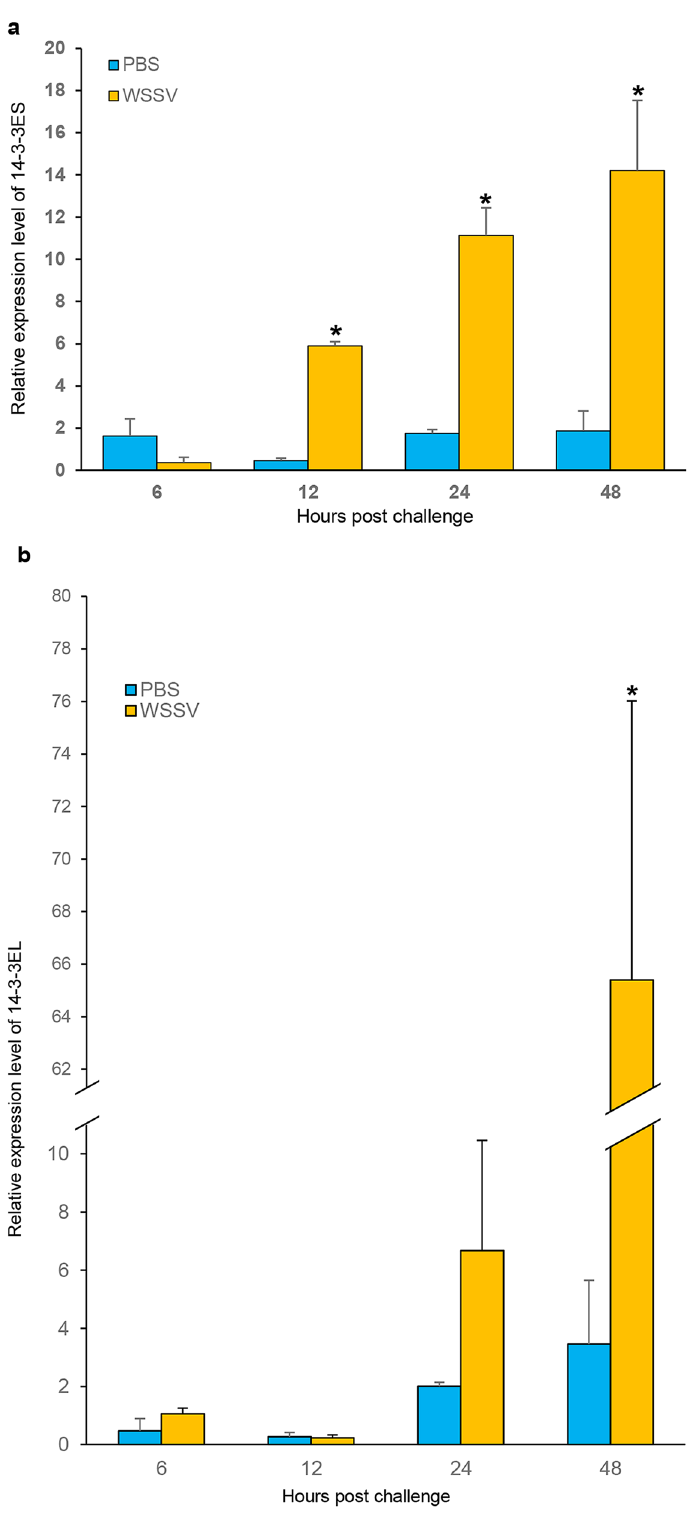
Figure 6. Expression profile of the 14-3-3ε transcripts in L. vannamei at various time points during WSSV infection . The expression profiles of 14-3-3ES ( a ) and 14-3-3EL ( b ) were determined in the hepatopancreas of WSSV- challenged shrimp at various time points during infection. Error bars indicate standard deviations (n = 3/time point). Asterisks indicate significant differences ( p < 0.05) compared with the values of the